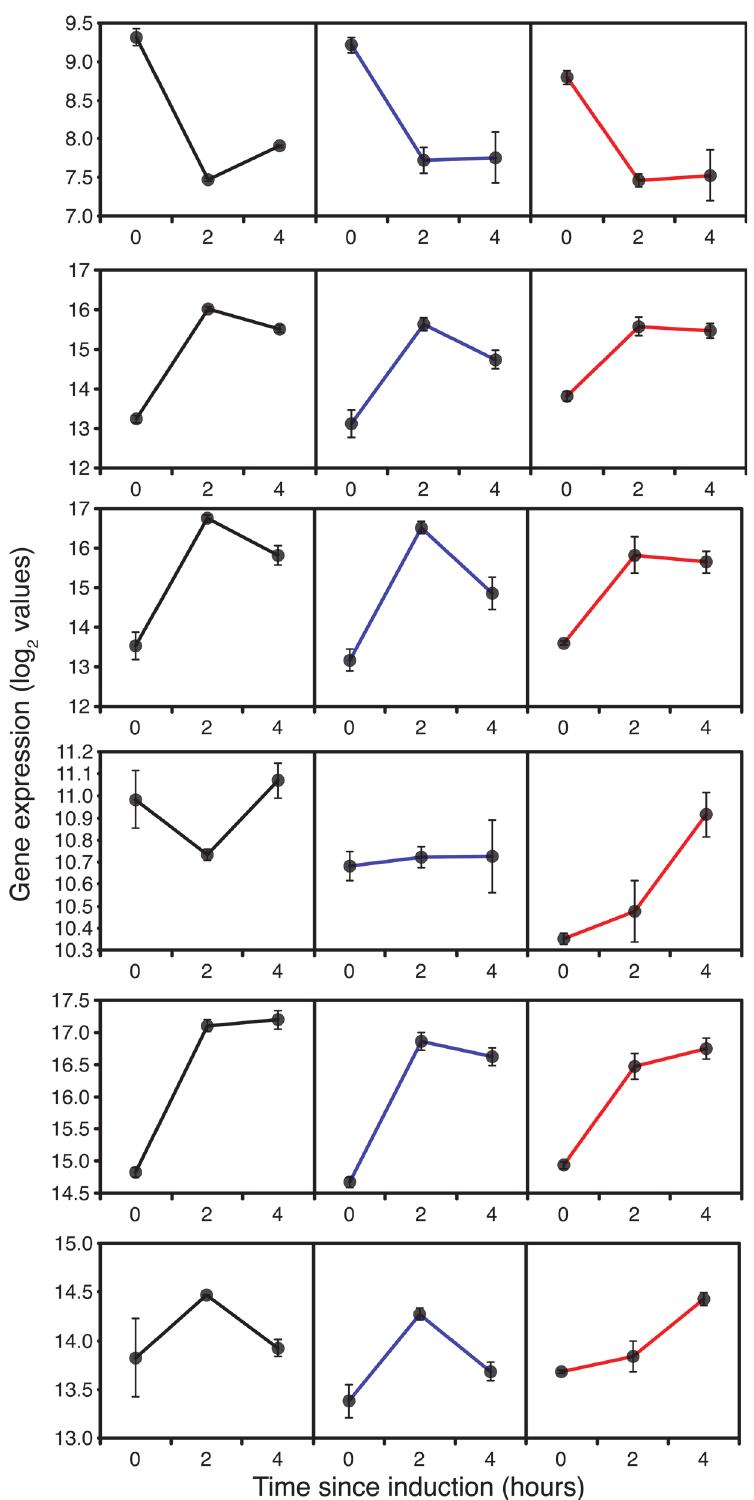
Fig 7. Expression of starvation and stress response genes, 0 (before), 2 and 4 hours after the start of methanol addition to wild-type GS115 (black), TRY1-1 (blue) and TRY1-3 (red), strains containing 1 and 3 gene copies of the human typsinogen gene, respectively, under the control of the AOX1 promoter. From top to bottom, panels represent GCN4 , TRX2 , TSA1 , AHP1 , SOD1 , SOD2 . Error bars show SEM.